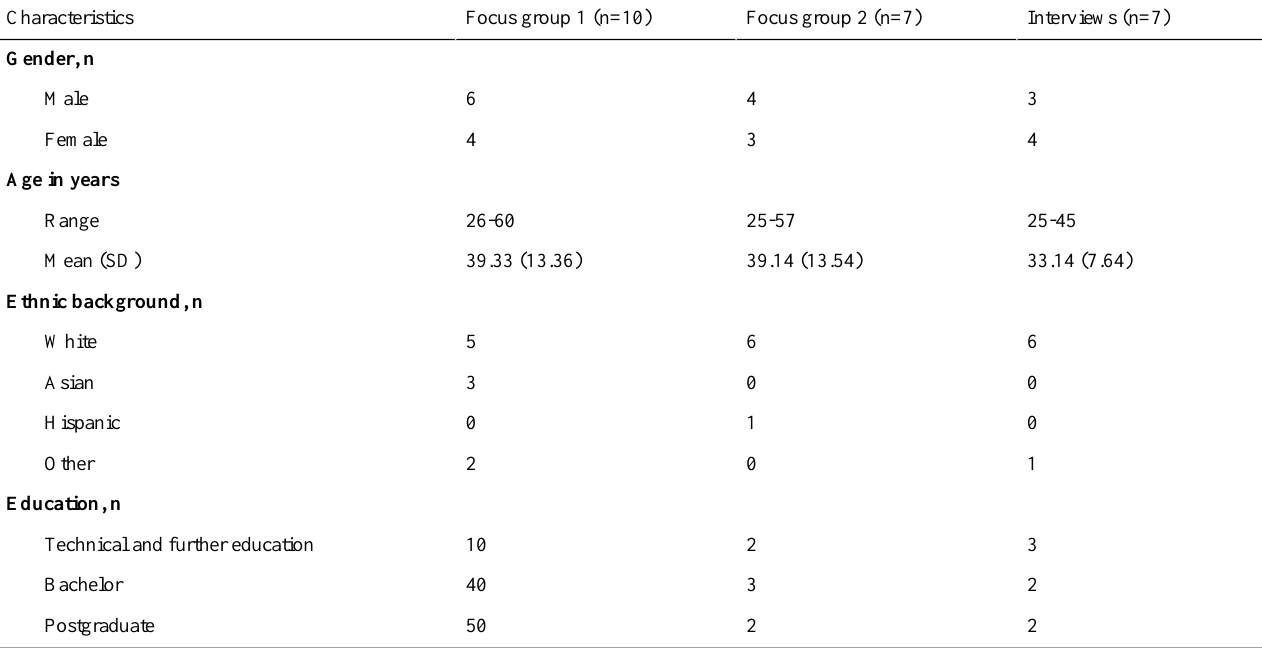
Table 1. Characteristics of focus group and interview